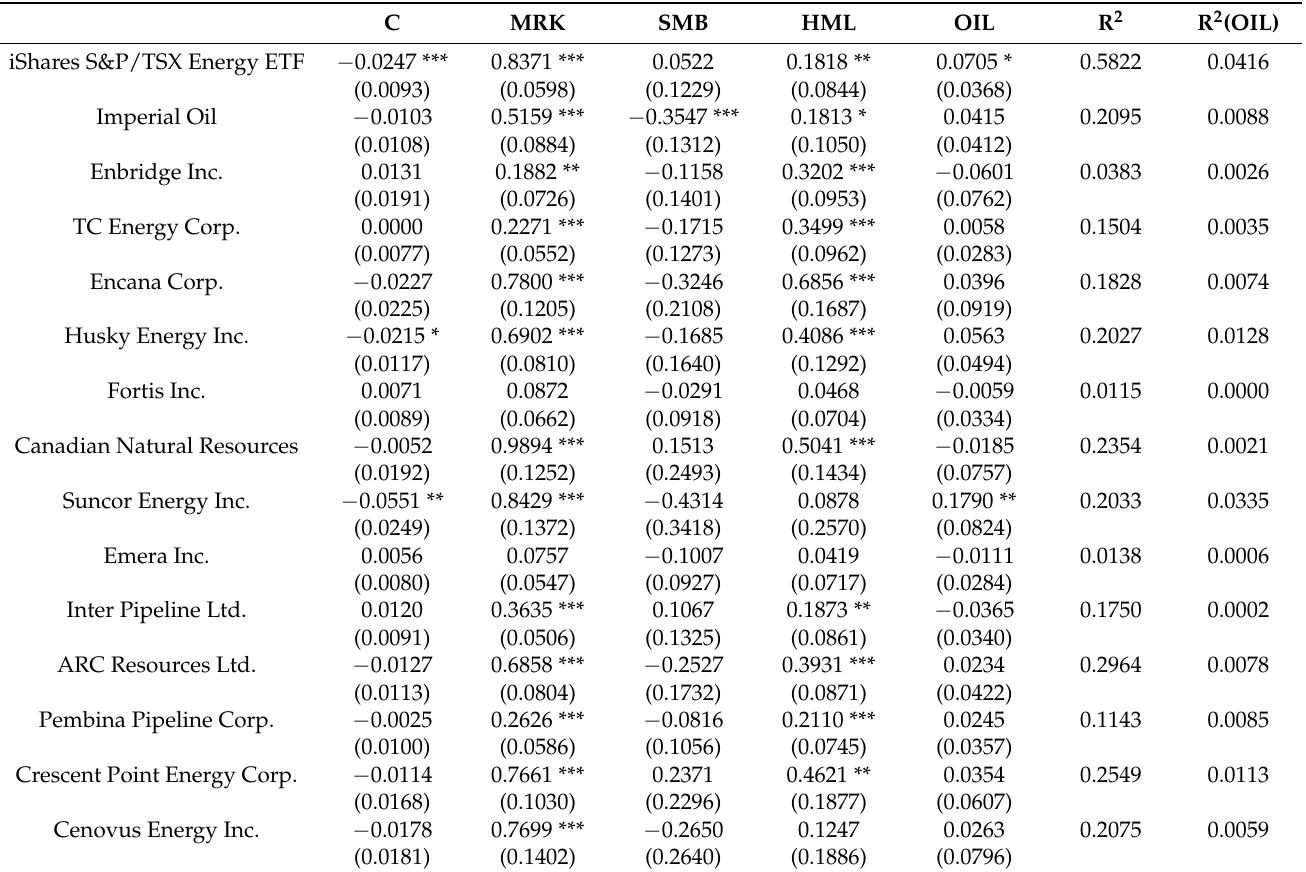
Table 4. Regression results—with